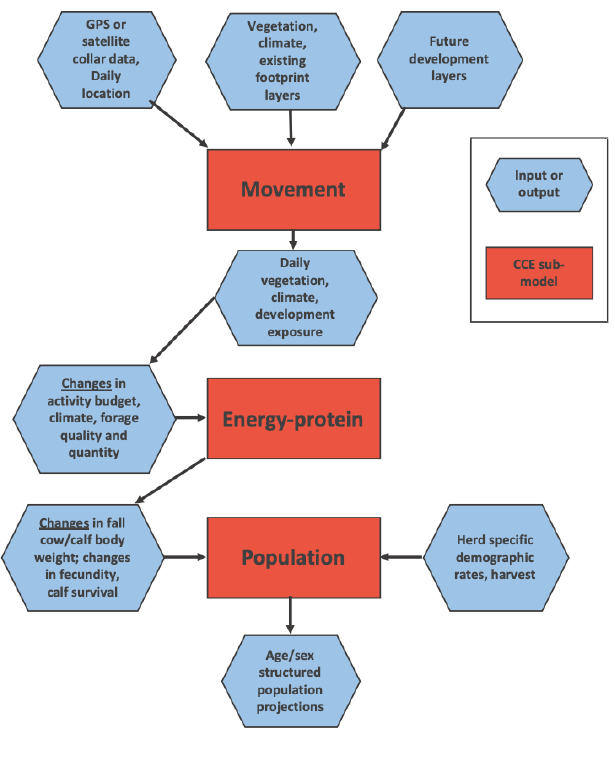
Fig. 1 . Schematic of the caribou cumulative effects (CCE) model showing submodel components in red and various submodel inputs/outputs in